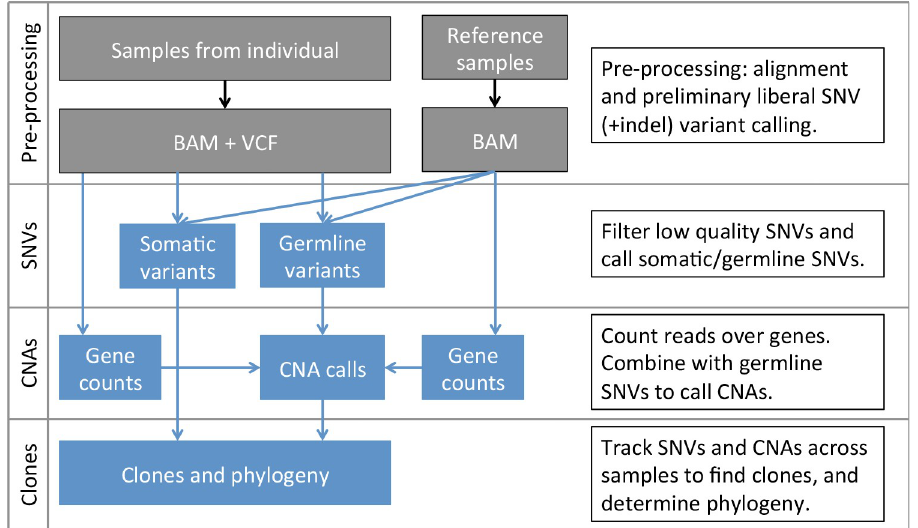
Fig 1. The SuperFreq workflow. The input is aligned BAM files from the samples under study, and at least 2 reference normals (5–10 recommended, see methods), as well as liberal variant calls. SuperFreq filters the preliminary SNVs for artefacts using quality scores in the BAM file, and through comparison to the reference normals. Somatic SNVs are called from the remaining variants, while heterozygous germline SNPs are identified for CNA calling. CNAs are identified based on differences in coverage and detecting shifts in allele frequency at heterozygous germline SNPs. Finally, somatic SNVs and CNAs are analysed across samples to designate and track clones.